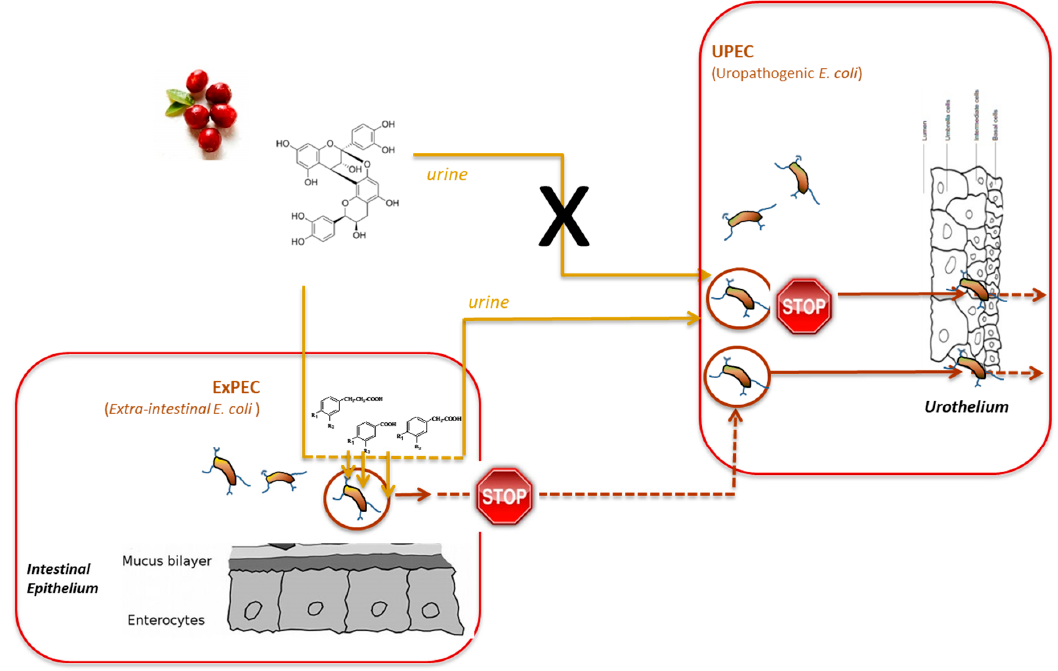
Figure 2. Proposed mechanisms of cranberry polyphenols action against urinary tract infections (UTIs).